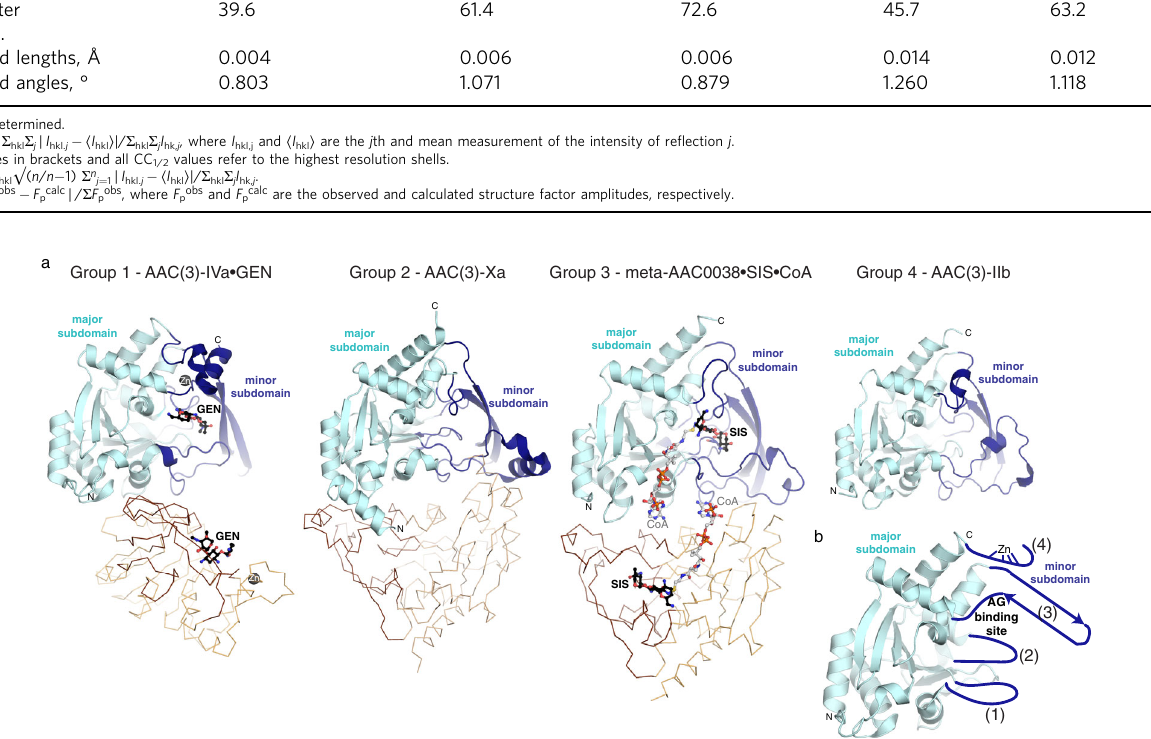
(Fig. 3b) forms an extended loop structure of variable length while adopting a helical structure in AAC(3)-Xa, meta-AAC0038, and AAC(3)-IIb but not in AAC(3)-IVa. Insert 2 forms a short